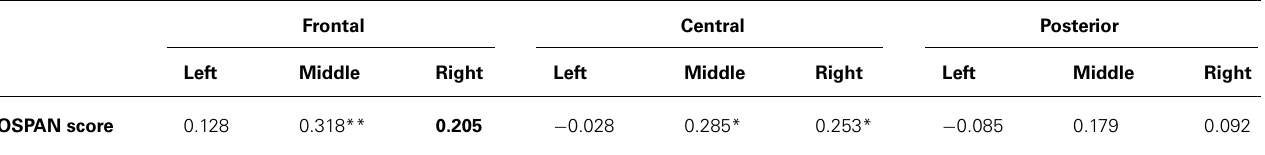
Table 3 | Correlation coefficients between OSAPN score and theta power increase from lower (2 and 3 digits) to higher (4 and 5 digits) loads for all EEG clusters. Frontal Central Right Left Middle Right